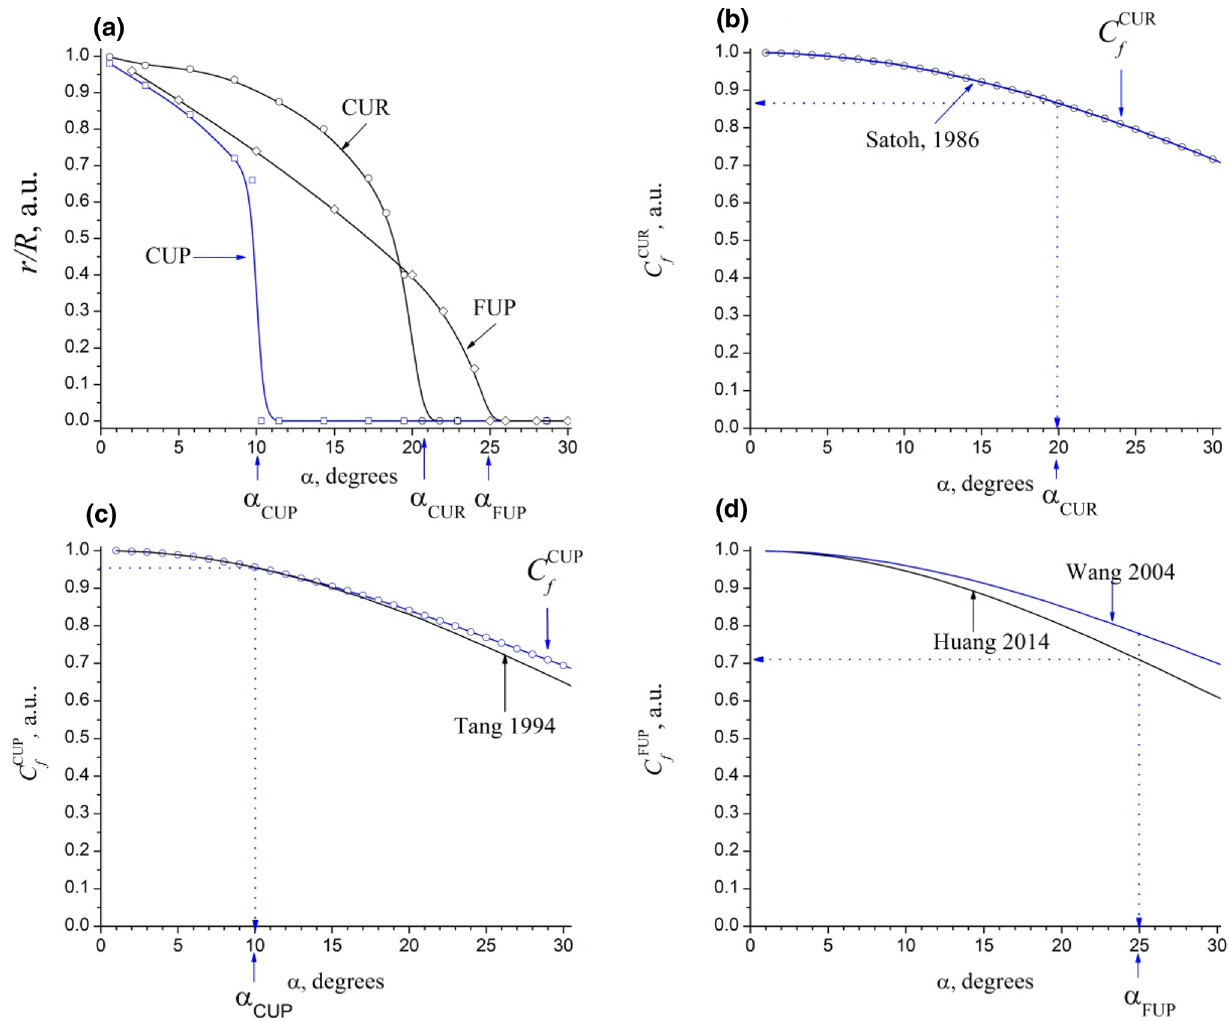
Fig. 1 a The plot illustrates how the angle subtended by the contact area determines the location with the greatest possibilities of failure initiation for each of the three load geometries studied. b Correction factor that must be used with the CUR setup; the factor derived by Satoh (1986) and the one derived in this work are shown. c Correction factor that must be used with the CUP loading geometry; the factor derived by Tang and the one derived in this work are shown. d Correction factor that must be used with the FUP setup; the factor derived by Wang et al. (2004) and the one derived by Huang et al. (2014) are